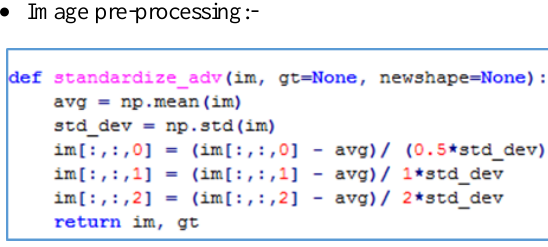
Figure 3. Pseudocode for modified standardization used as pre-processing